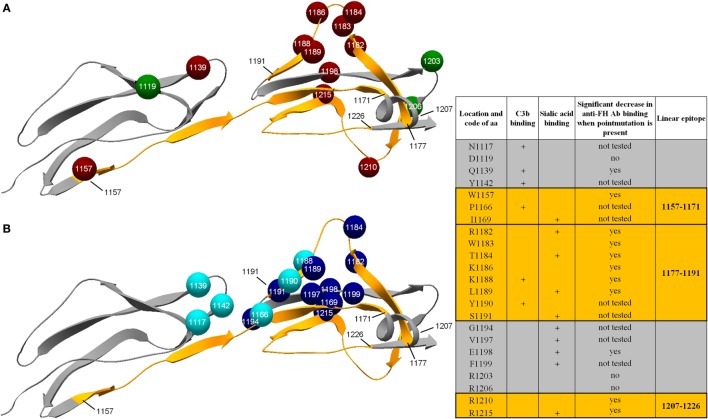
Folded structure of complement factor H (FH) short consensus repeat domains 19–20. Panels represent the ribbon model of the molecule obtained from the Protein Data Bank (pdb2g7i). Linear epitopes of the FH autoantibodies are highlighted with orange [amino acid (aa)1157–1171, aa1177–1191, and aa1207–1226], where the initial and final aa of each segment is indicated with black numbers. Arrowheads point toward the C-terminal end of the proteins. (A) The location of the generated point mutations is displayed as colorful spheres on the backbone of the protein, with white numbers indicating their location and colors their effect on autoantibody binding by FH (red: significantly decreased binding when the aa substitutions is present; green: no significant effect on binding). (B) Colorful spheres refer to aa forming the C3b (14, 35) (light blue) and sialic acid (15) (dark blue) binding sites of the molecule. Numbers within the spheres show the location of each aa.